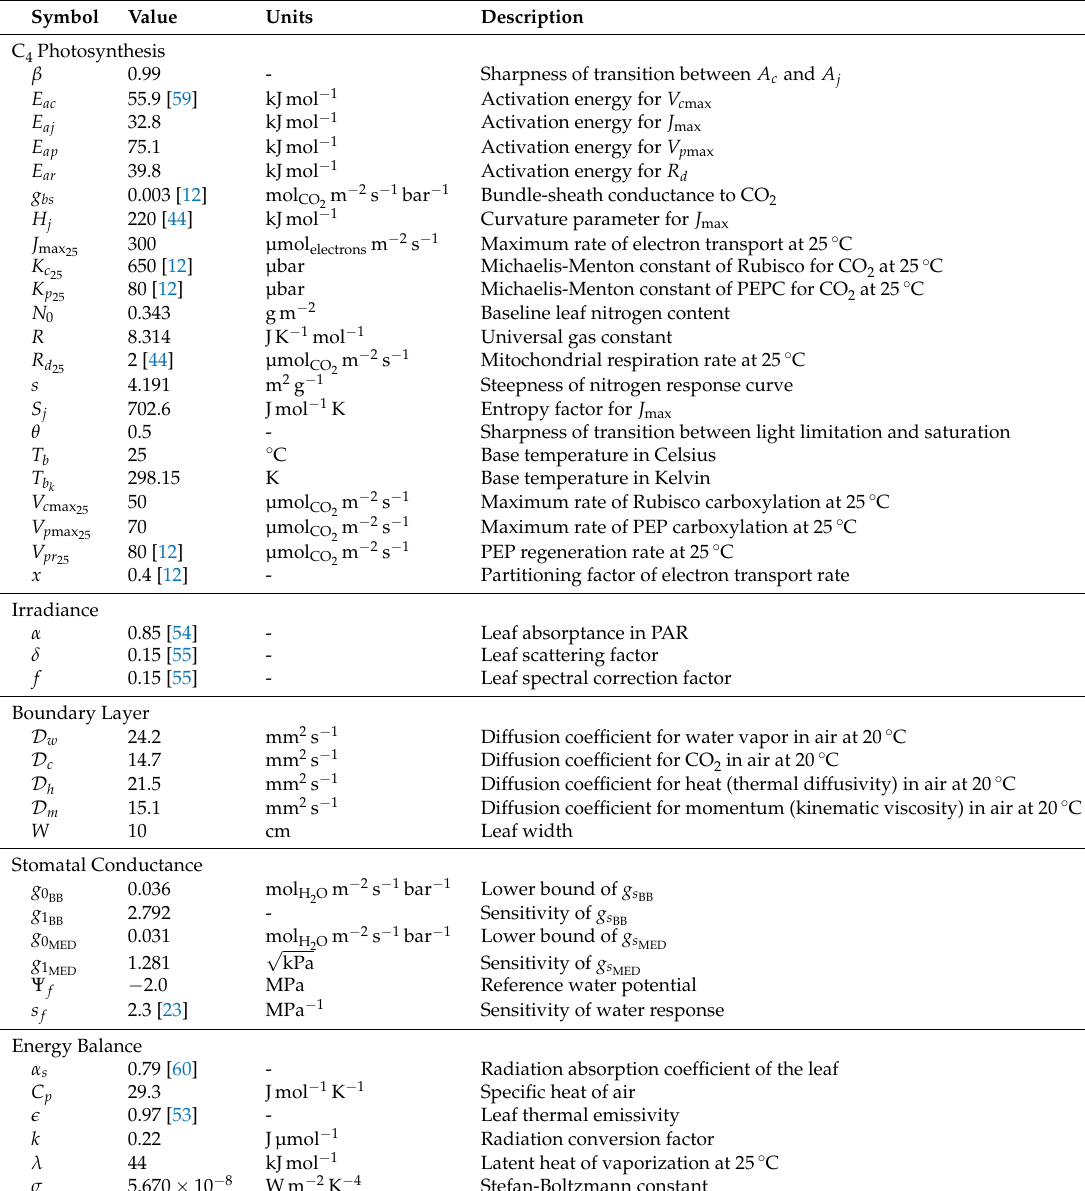
Table A2. Parameters and constants used in the model.